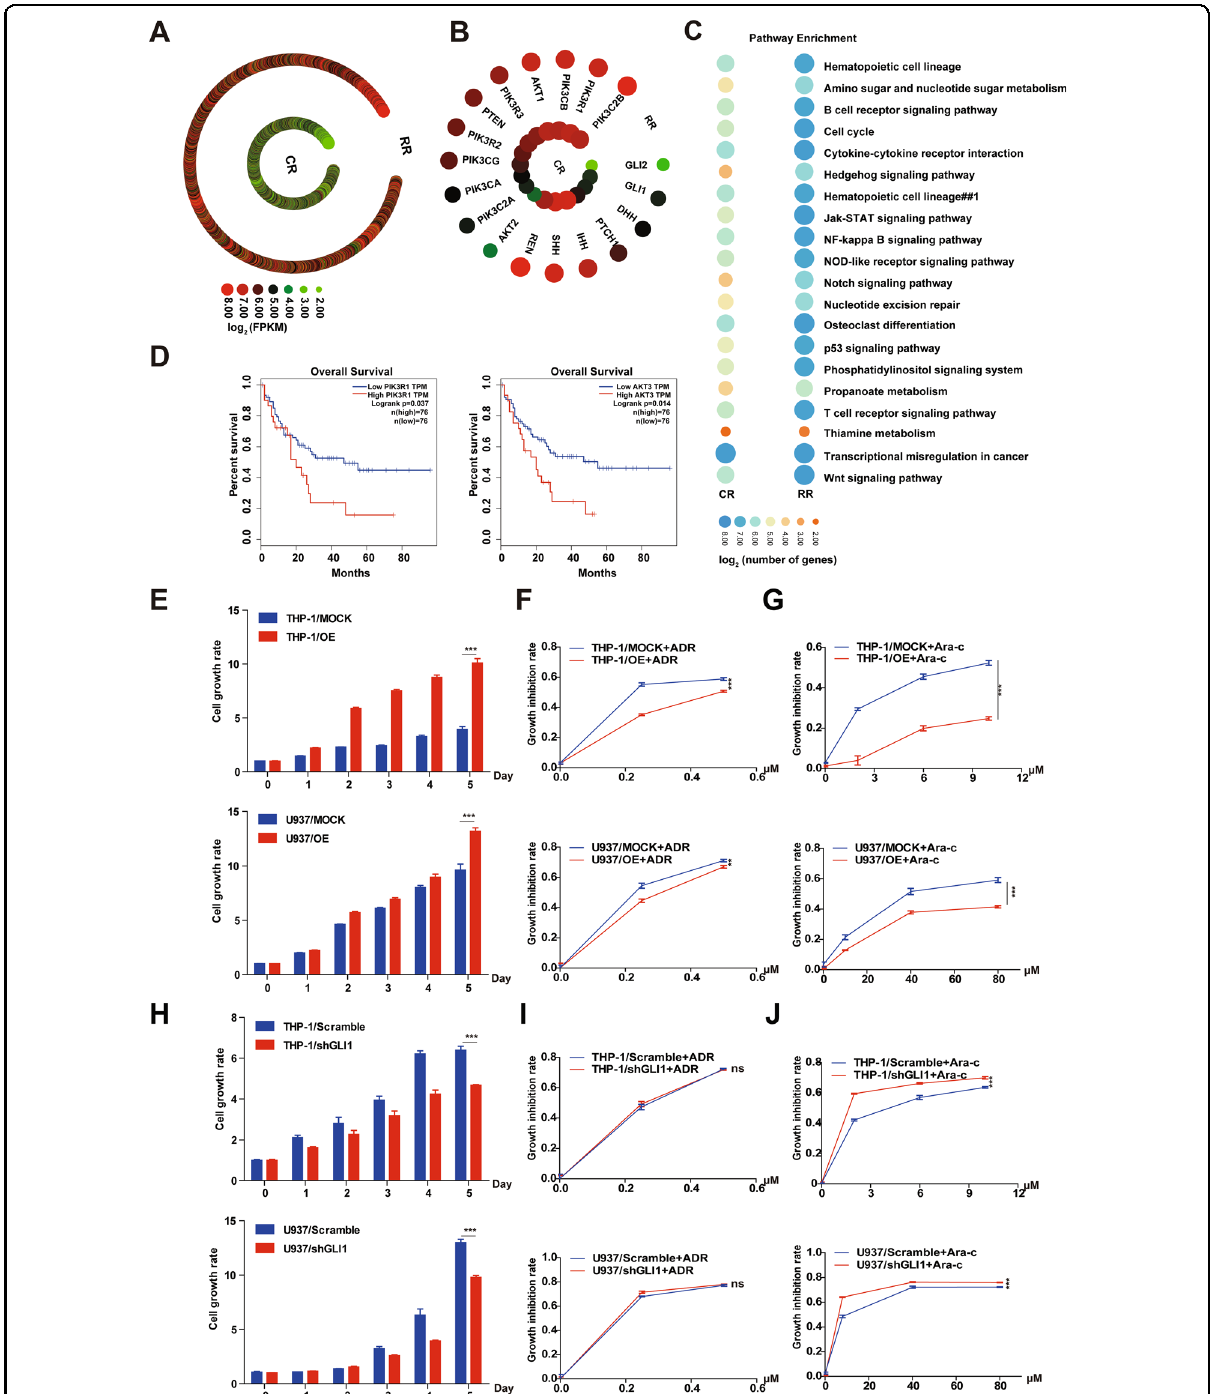
Fig. 1 GLI1 regulates AML cell proliferation and reduces drug sensitivity. A , B Heatmap of all genes. Hh and PI3K/AKT pathway-related gene expression for 22 AML-RR patients and 22 AML-CR patients. C Pathways enriched in AML-RR compared to AML-CR patients with the top 20 pathways shown. D Kaplan – Meier curves of PIK3R1 and AKT3 for AML patients derived from the GEPIA database. E The growth rate of THP-1/MOCK/OE and U937/MOCK/OE cells was determined by Cell Counting Kit-8 assay. F , G Growth inhibition rates of THP-1 and U937 MOCK/OE cells treated with different concentrations of ADR/Ara-c. H The growth rates of THP-1/Scramble/shGLI1 and U937/Scramble/shGLI1 cells were determined by Cell Counting Kit-8 assay. I , J Growth inhibition rates of THP-1 and U937 Scramble/shGLI1 cells treated with different concentrations of ADR/Ara-c. p values were obtained by two-way ANOVA. * P < 0.05, ** P < 0.01, *** P < 0.001, ns not signi fi